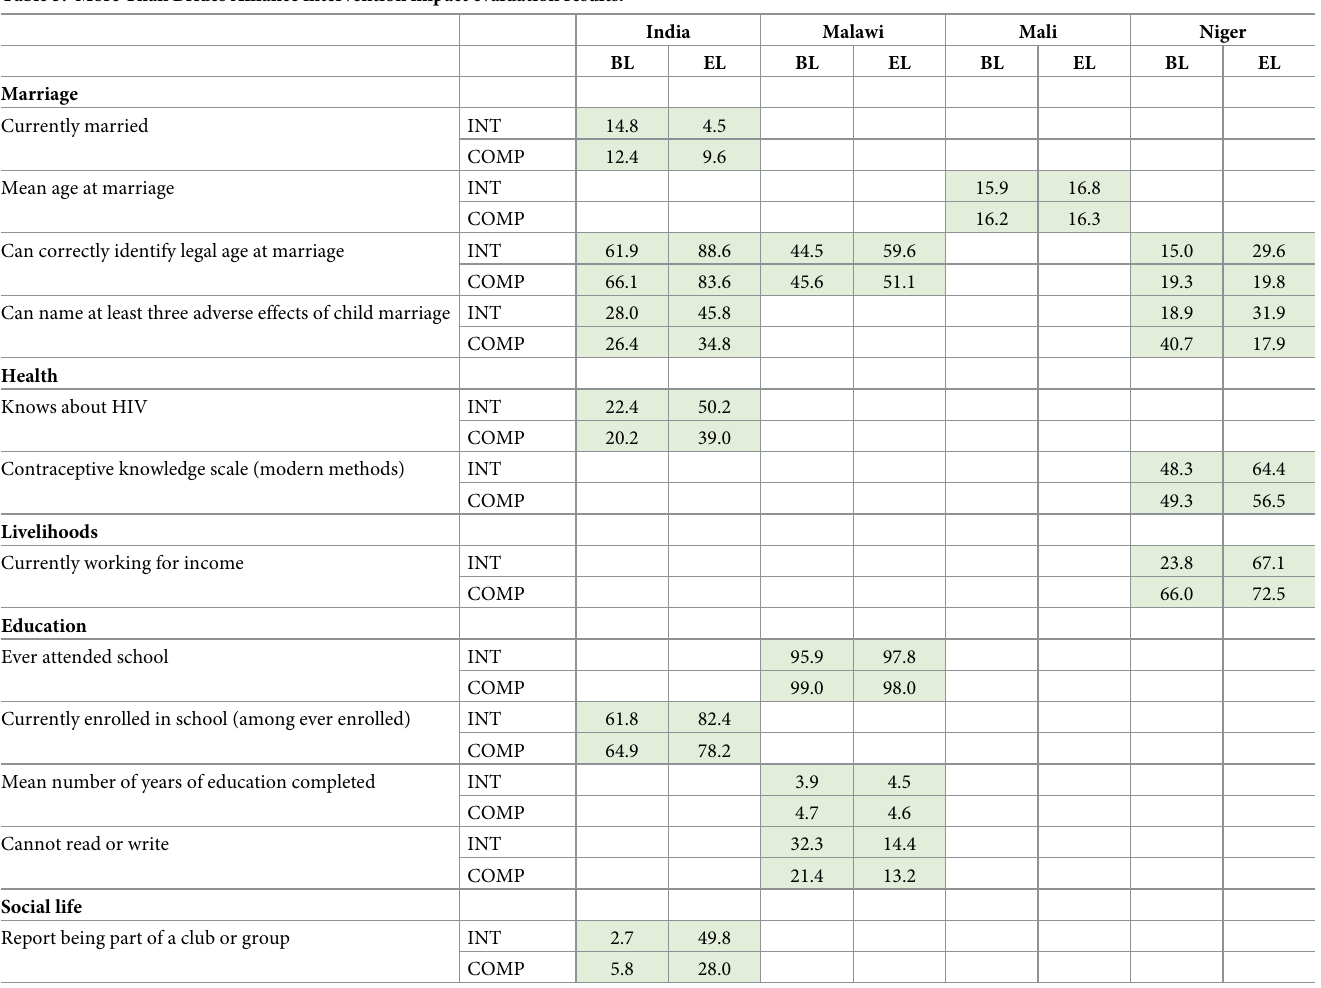
Table 3. More Than Brides Alliance intervention impact evaluation